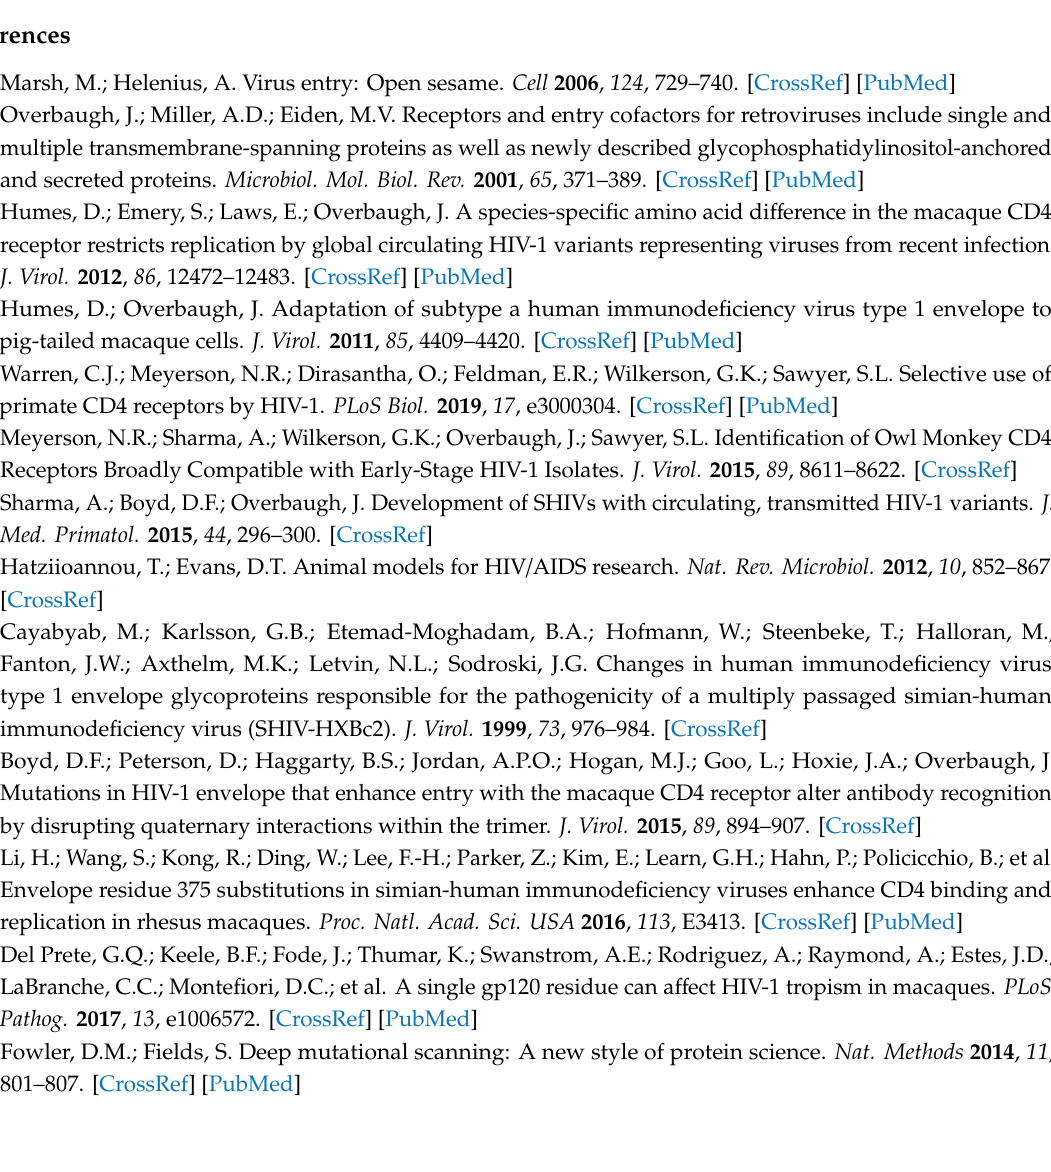
Figure S1: Wild-type BF520 infection of 293T cells engineered to express either macaque or human CD4 / CCR5 receptors, Figure S2: Expression of CD4 and CCR5 on 293T rhm and 293T hu cells. Table S1: Fold-change relative to the wild-type residue for all mutants that were enriched greater than 10-fold following either 293T rhm or 293T hu infection in the